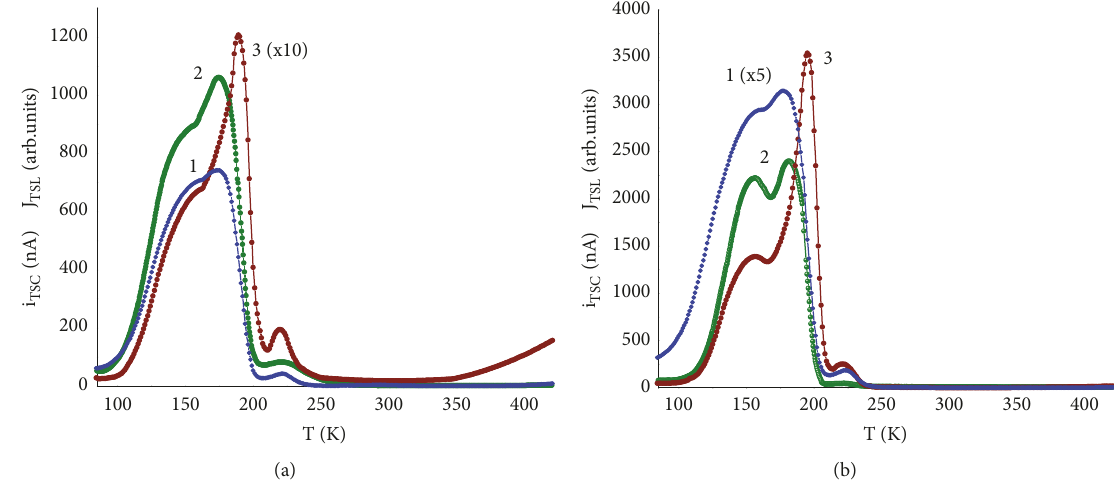
Figure 4: TSC (1) , TSL-630 (2) , and TSL-970 (3) curves of ZnSe sample #2: at a low dose of radiation ( 𝐷 X = 7.8 mJ/cm 2 ) (a) and at a high dose of radiation ( 𝐷 X = 4608 mJ/cm 2 )